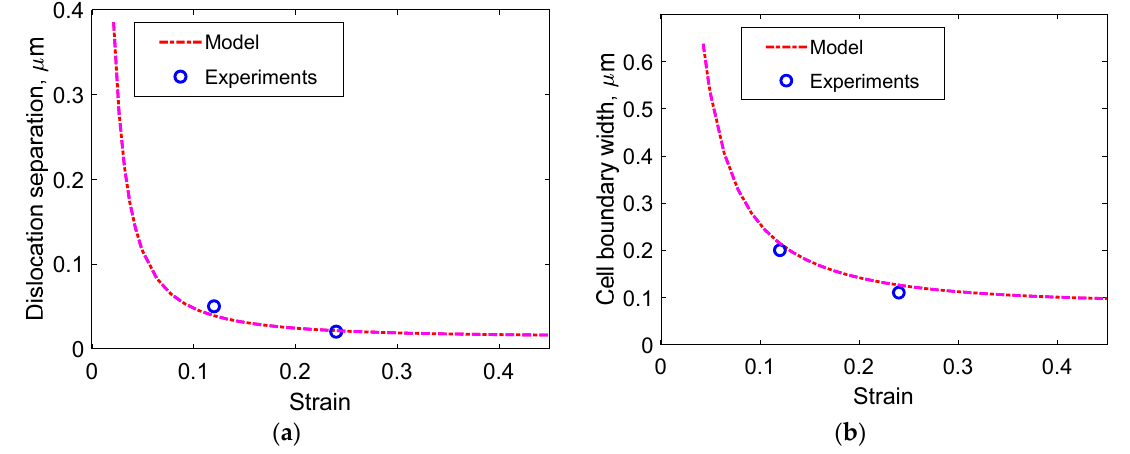
Figure 6. ( a ) Dislocation separation in the cell boundaries and ( b ) cell boundary width as a function of strain for Cu-OFP at 75 °C and 1 × 10 − 5 1/s. Experimental data from [3]. Redrawn with permission from ref. [16]. Copyright 2022 Elsevier.